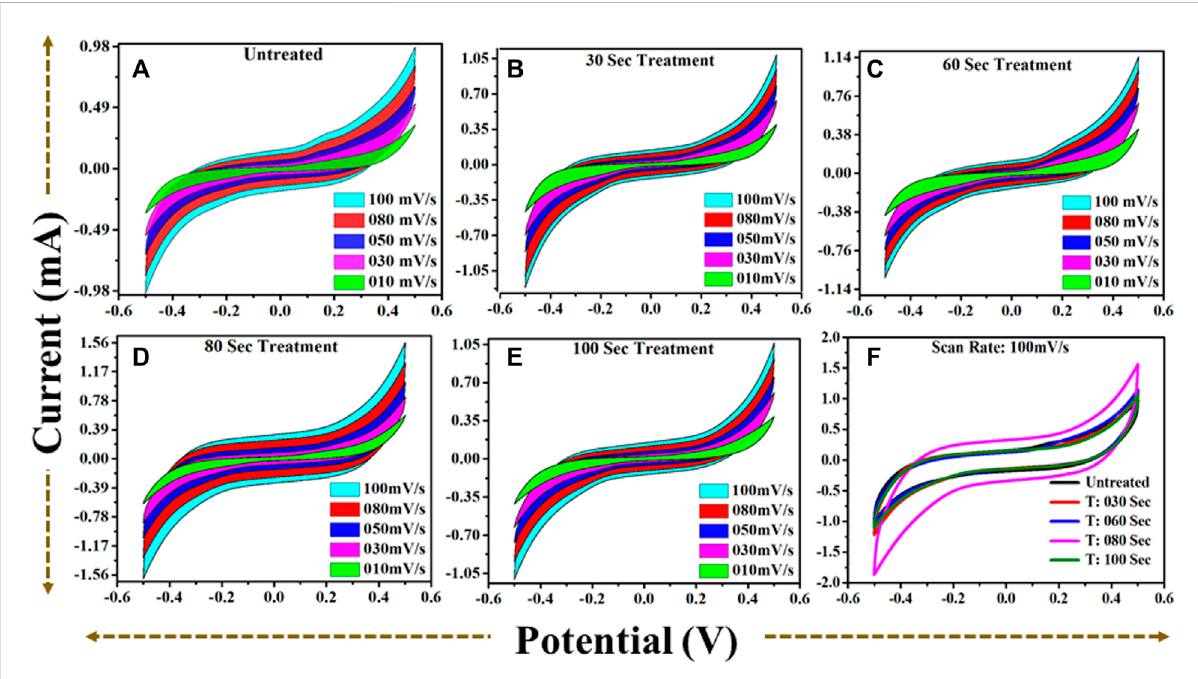
FIGURE 8 (A) : CV pro fi le for untreated TiO2 @scan rate (10 – 100) mV/s. (B) : CV pro fi le for 30 s plasma treated TiO2 @scan rate (10 – 100) mV/s. (C) : CV pro fi lefor60 splasmatreatedTiO2@scan rate(10 – 100)mV/s. (D) :CVpro fi lefor80 splasmatreated TiO2@scan rate(10 – 100)mV/s. (E) :CVpro fi